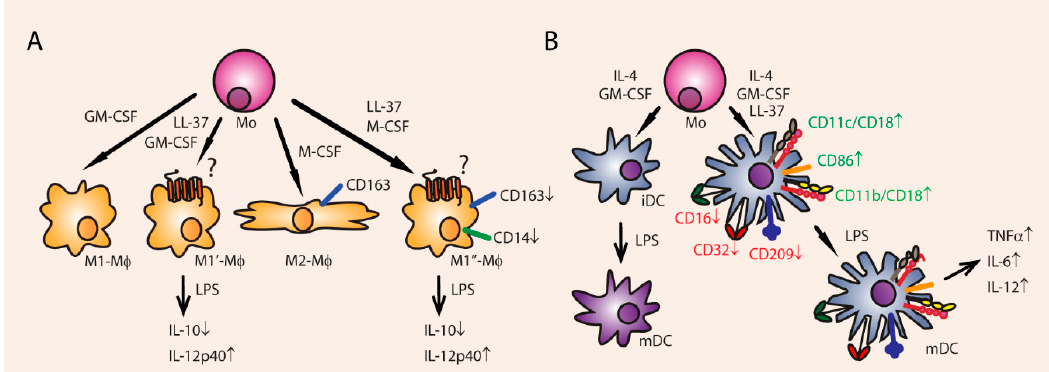
Figure 6. LL-37 effects on cell differentiation. ( A ) Exposure of M2 macrophages to LL-37 polarizes them into a more inflammatory (M1) phenotype, leading to a downregulation of CD163 and